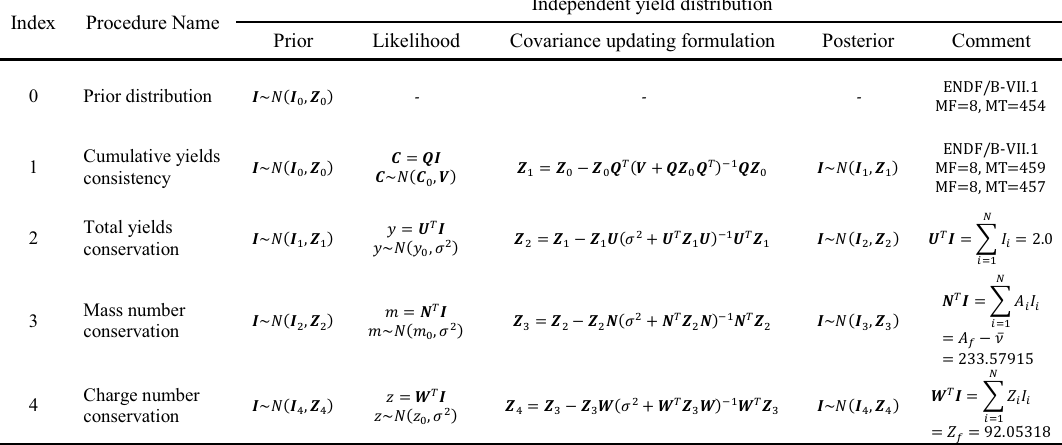
Table II. Bayesian Updating Process for Independent Yields Covariance